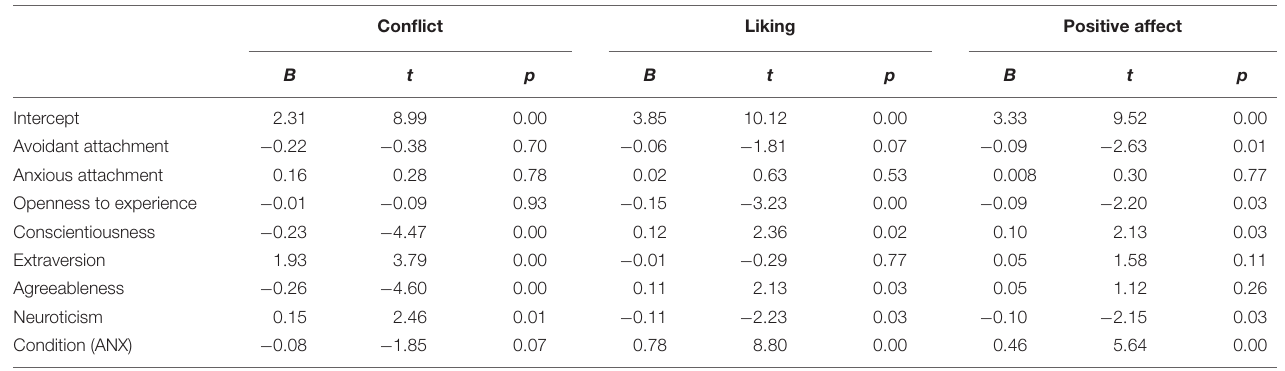
TABLE 3 | Main effect of covariates (Study 1) for Conflict, Liking and Positive Affect as dependent variables. Conflict